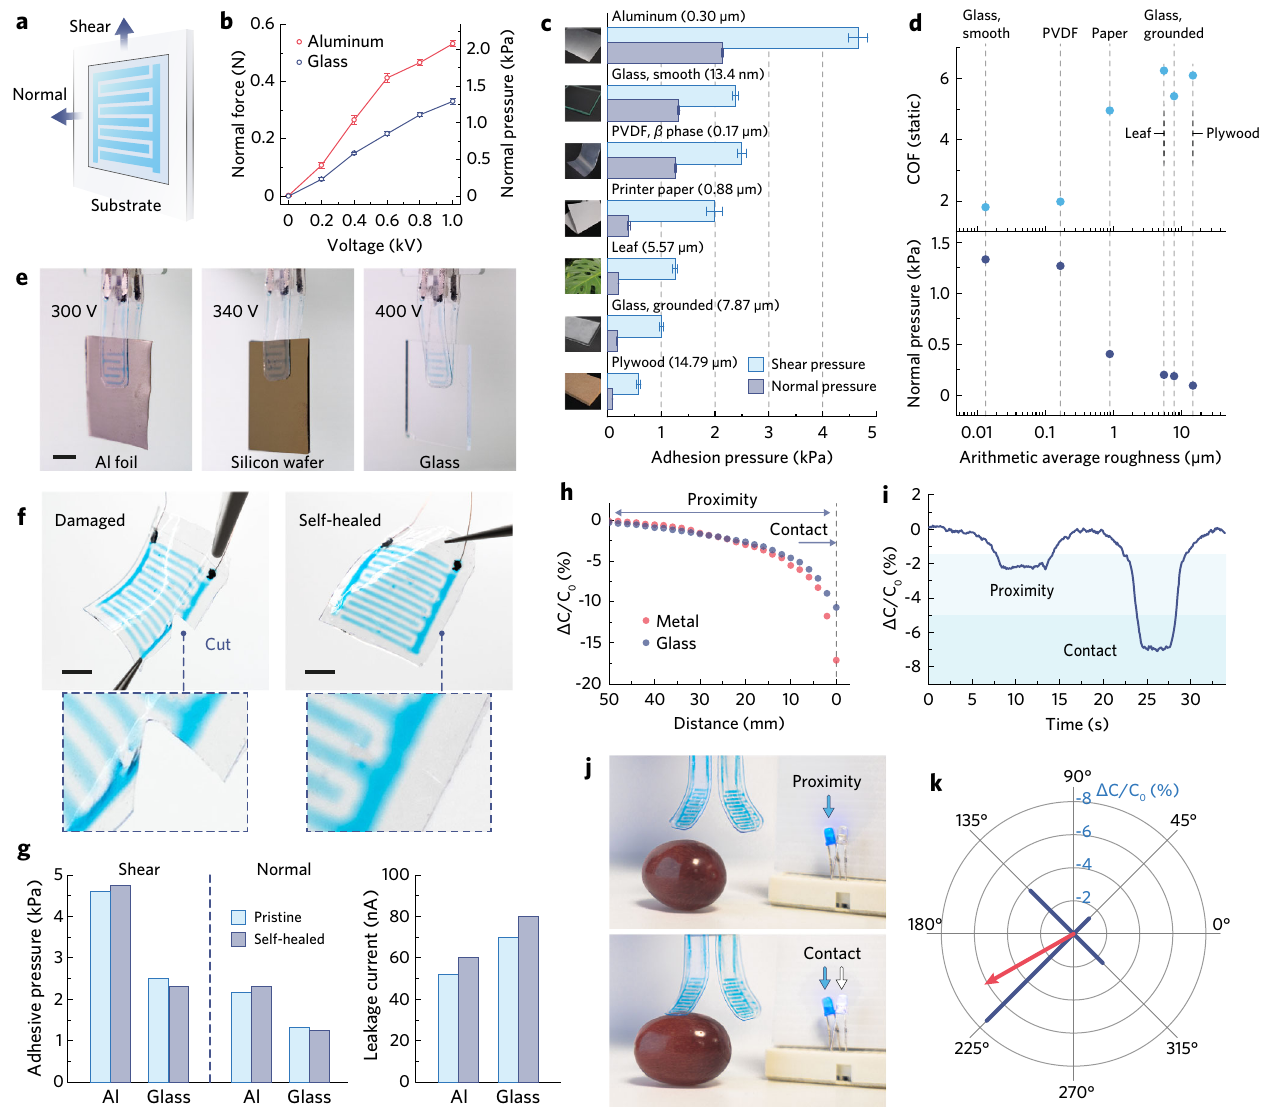
Fig. 5 | Adhesion performance and exteroceptive sensation. a Schematic illus- tration depicting the testing methods for normal and shear adhesion pressures. b Recorded normal adhesion force (and pressure) of iontronic-adhesive patch on aluminum/glass substrates under varying voltage inputs (same sample measured repeatedly, mean±s.d., n =5). c Recorded normal and shear adhesion pressure between the iontronic-adhesive patch and various substrates under 1kV (same sample measured repeatedly, mean ± s.e., n =5). d Analysis of the correlation between COF, normal adhesion, and S a . e Photographs showing a two- fi ngered gripper picking up aluminum foil, silicon wafer, and smooth glass (from left to right) under low driving voltage. Scale bars, 5mm. f Photographs showing an iontronic-adhesive patch before and after self-healing from a cut damage. Scale